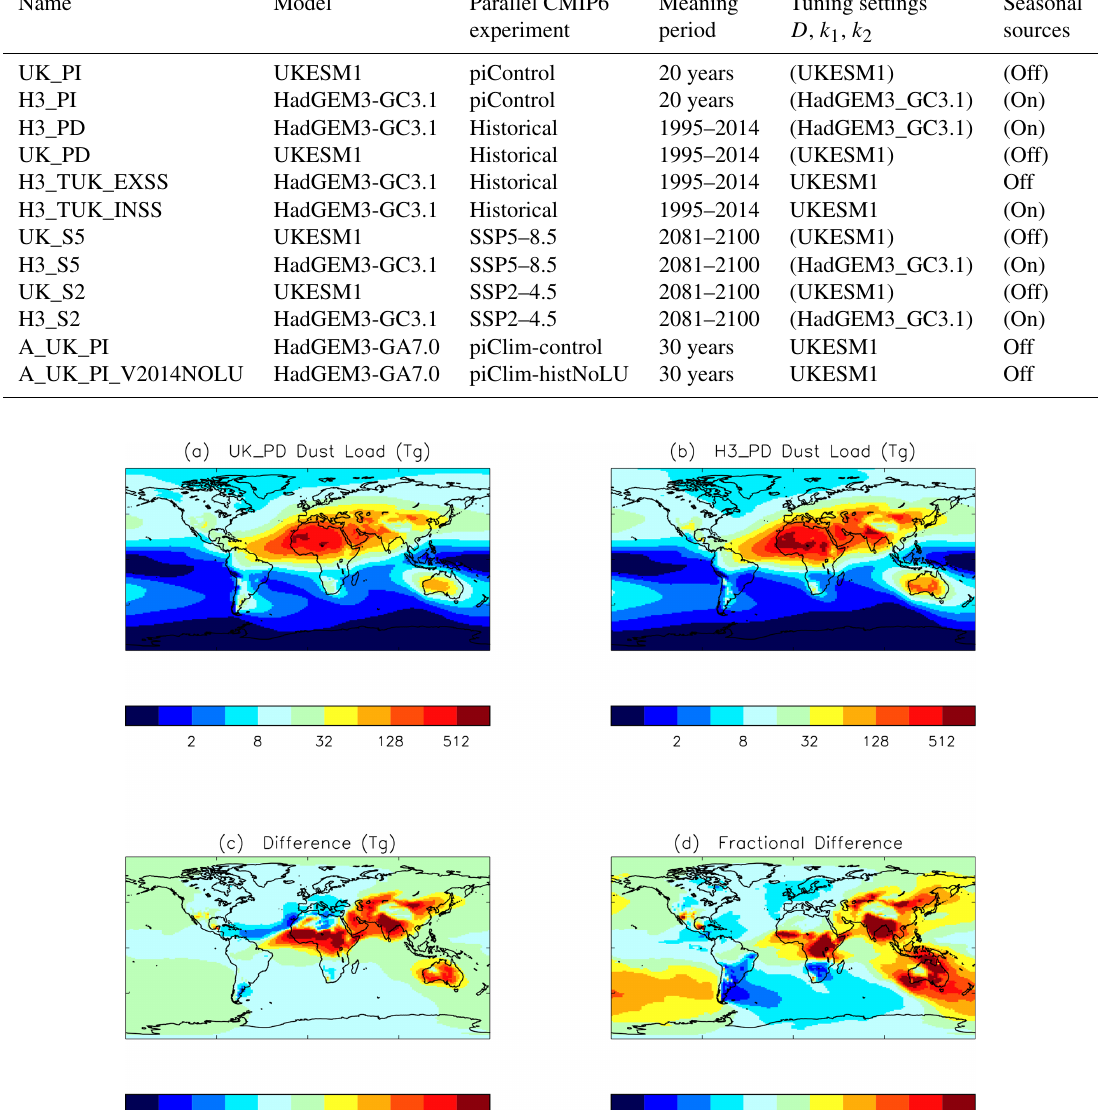
ment with observations, compared with other ESMs (Checa- Garcia et al., 2021). The similarity in the level of perfor- mance between UKESM1 and HadGEM3-GC3.1 is notewor- thy, given the many extra processes and feedbacks within the ESM and, in particular, its use of interactive